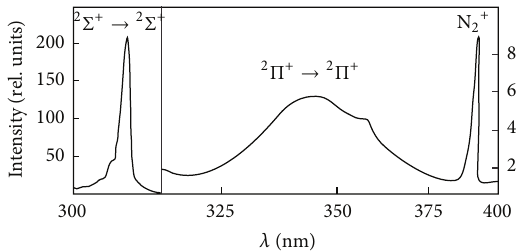
Figure 10: The emission spectrum of a mixture of 3 He: Xe: CCl 4 = 1500 :50:1 at Φ = 10 13 n/cm 2